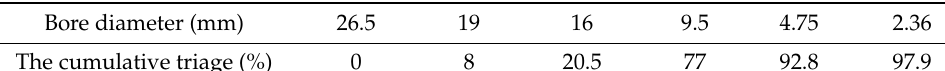
Table 3. Basic properties of the coarse coral aggregate and fine coral aggregate. Table 2. Accumulated retained percentage of coarse coral aggregate.